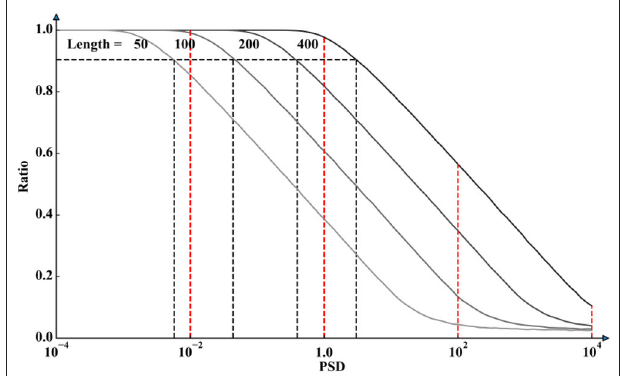
SD ; and (D) slope value 10 − 5 to 10 − 2 = ×